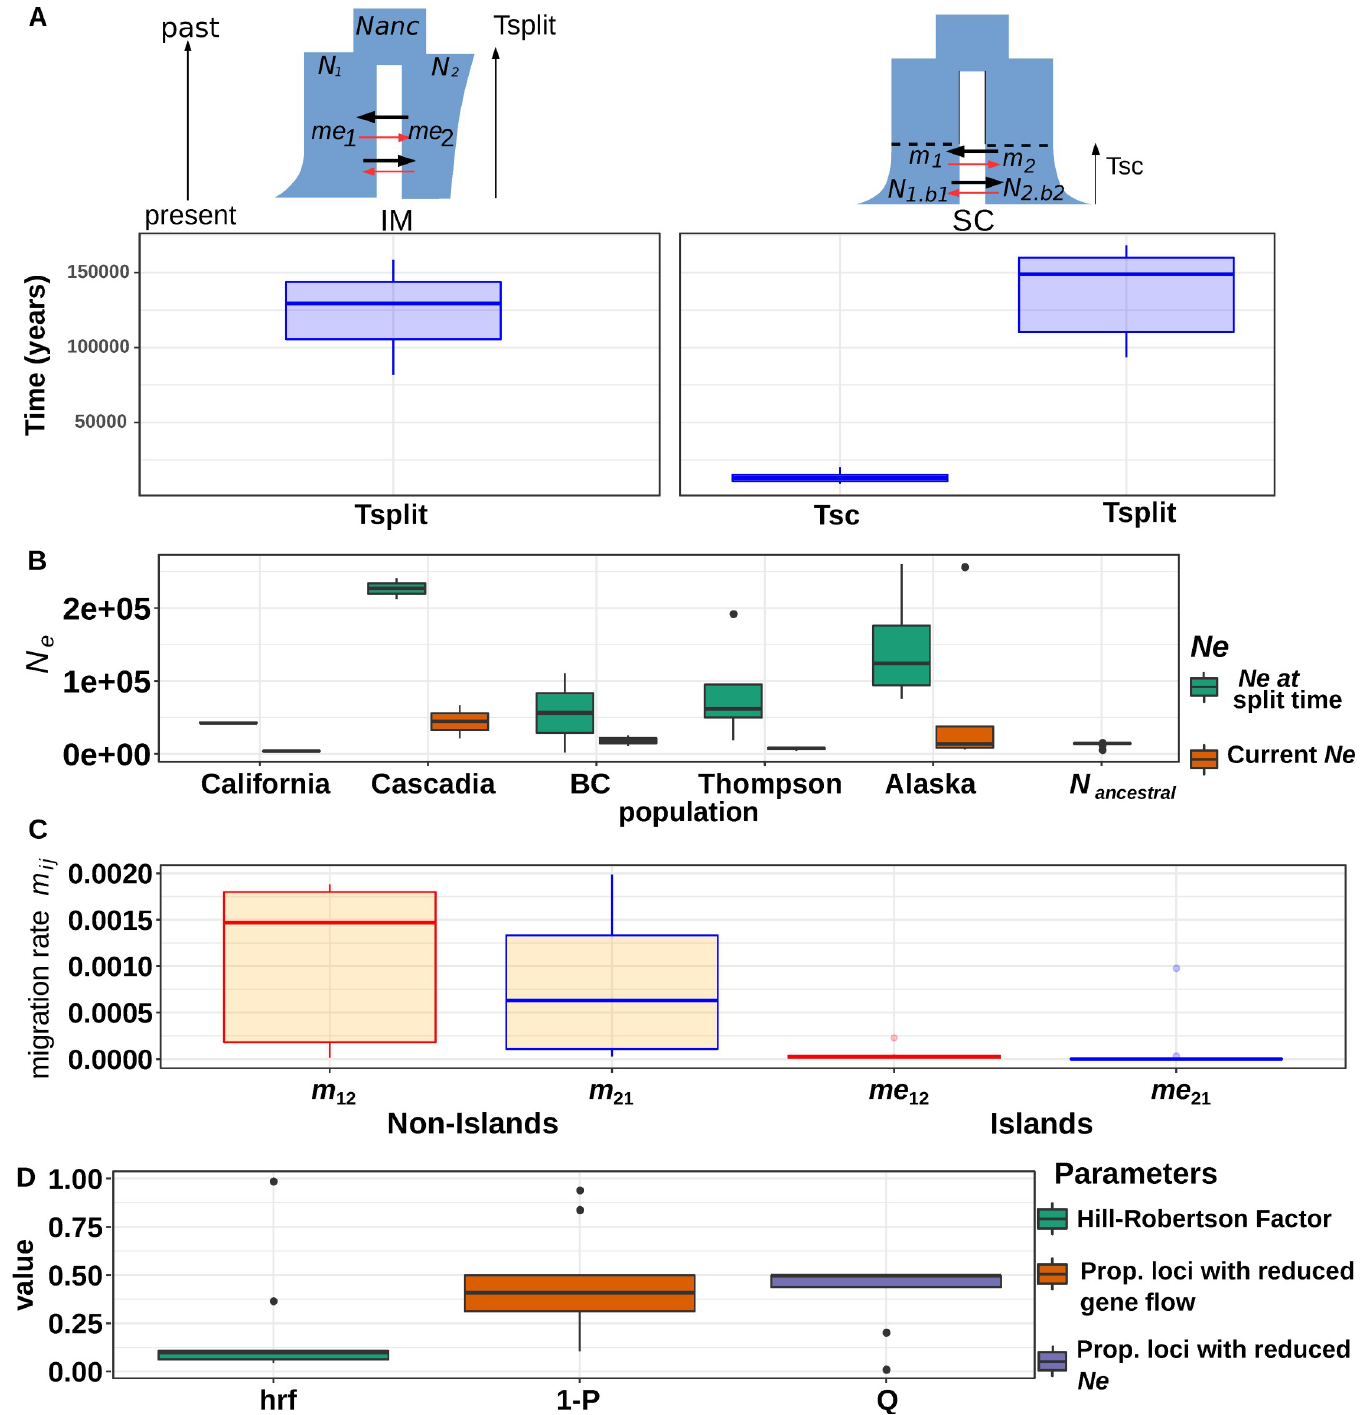
Fig 4. Inferences of demographic history using @ a @ i. A) Estimates of divergence time (in years) between each major region as inferred by @ a @ i under the best model (displayed in blue) based on SNP data. Plot displayed the parameter estimates for the best model for all pooled samples (IM = comparison between Alaska and all samples but Thompson SC = comparison between Thompson and all other samples as well as California versus Alaska) B) Estimates of effective population size Ne for each major region as inferred by @ a @ i under each best demographic model. Effective size are based on the best model including population size change. Three extreme values ( Ne > 2e6) were removed for readability). C) Estimates of migration rate among populations in neutral regions ( m ) of the genome and in areas of restricted recombination ( m e ) or islands of divergence. D) mean Hrf (Hill-Robertson factor) inferred across all comparisons. The Hrf estimates the extent of Ne reduction in areas affected by linked selection. Values are the averaged from multiple pairwise comparison across regions. Raw data are provided in S4 Table.